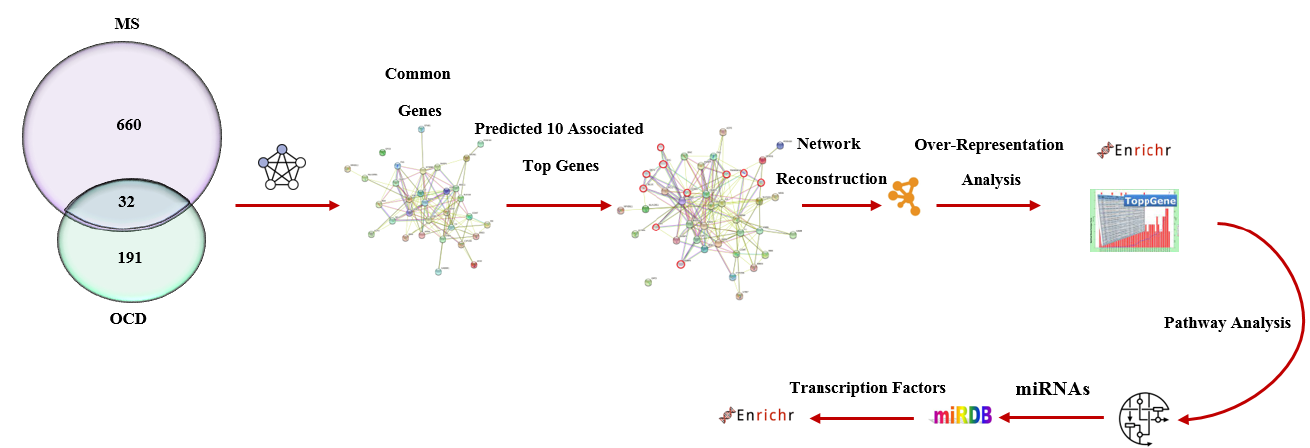
Figure 1. Flowchart of the main steps and bioinformatic tools in the current study. All genes associated with multiple sclerosis (MS) and obsessive-compulsive disorder (OCD) were extracted from the literature review and Harmonizome database. Then, 32 shared genes were identified between the two diseases. Next, novel genes based on protein–protein interactions with the highest connections with shared gene sets were predicted by the STRING database. The obtained genetic network was uploaded into Cytoscape to reconstruct a co-expression novel genetic network in a background of shared genes. Network parameters were also calculated through the Network Analyzer Toolkit in Cytoscape. All enrichment analysis was conducted on 10 predicted novel predicted genes.